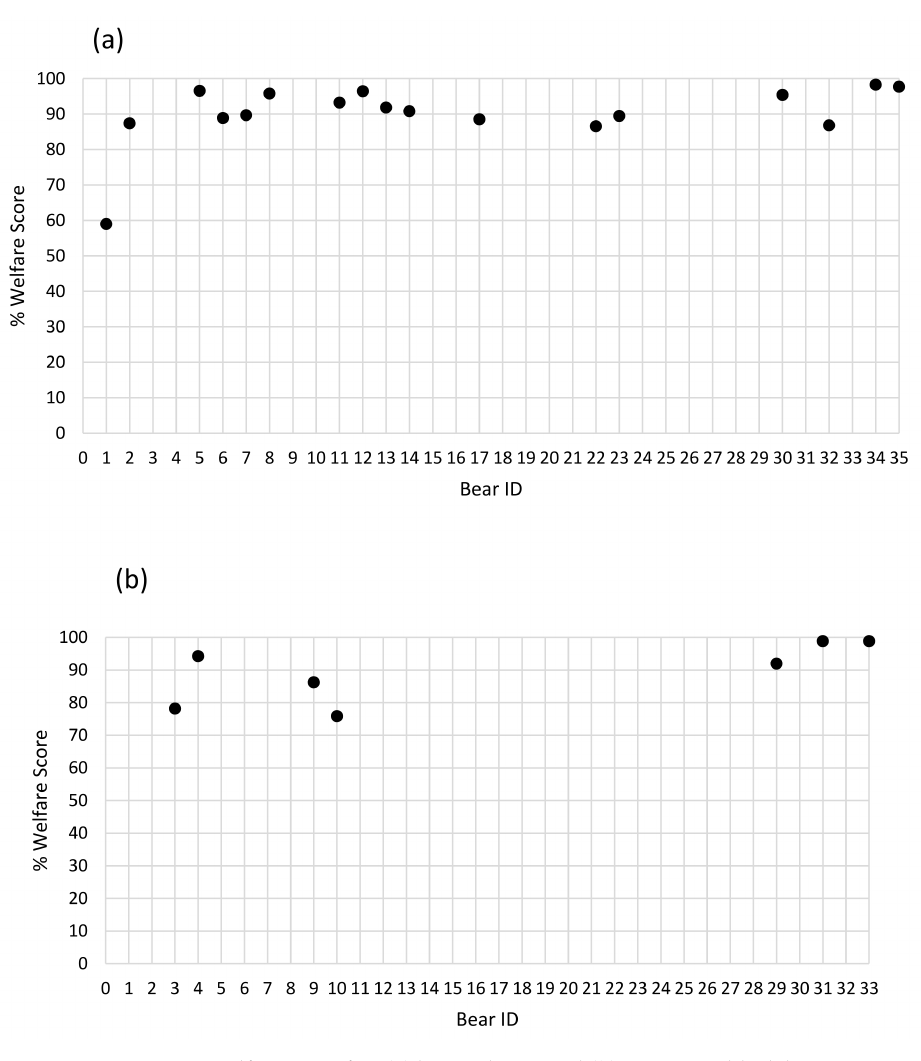
Figure 4. Percentage welfare score for: ( a ) brown bears and ( b ) American black